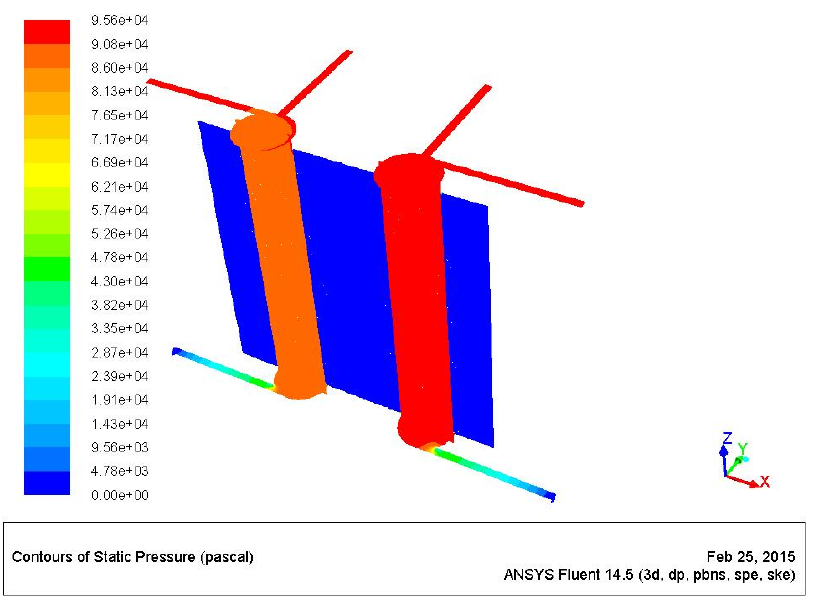
Figure 12. Overpressure map on the XZ and inlet